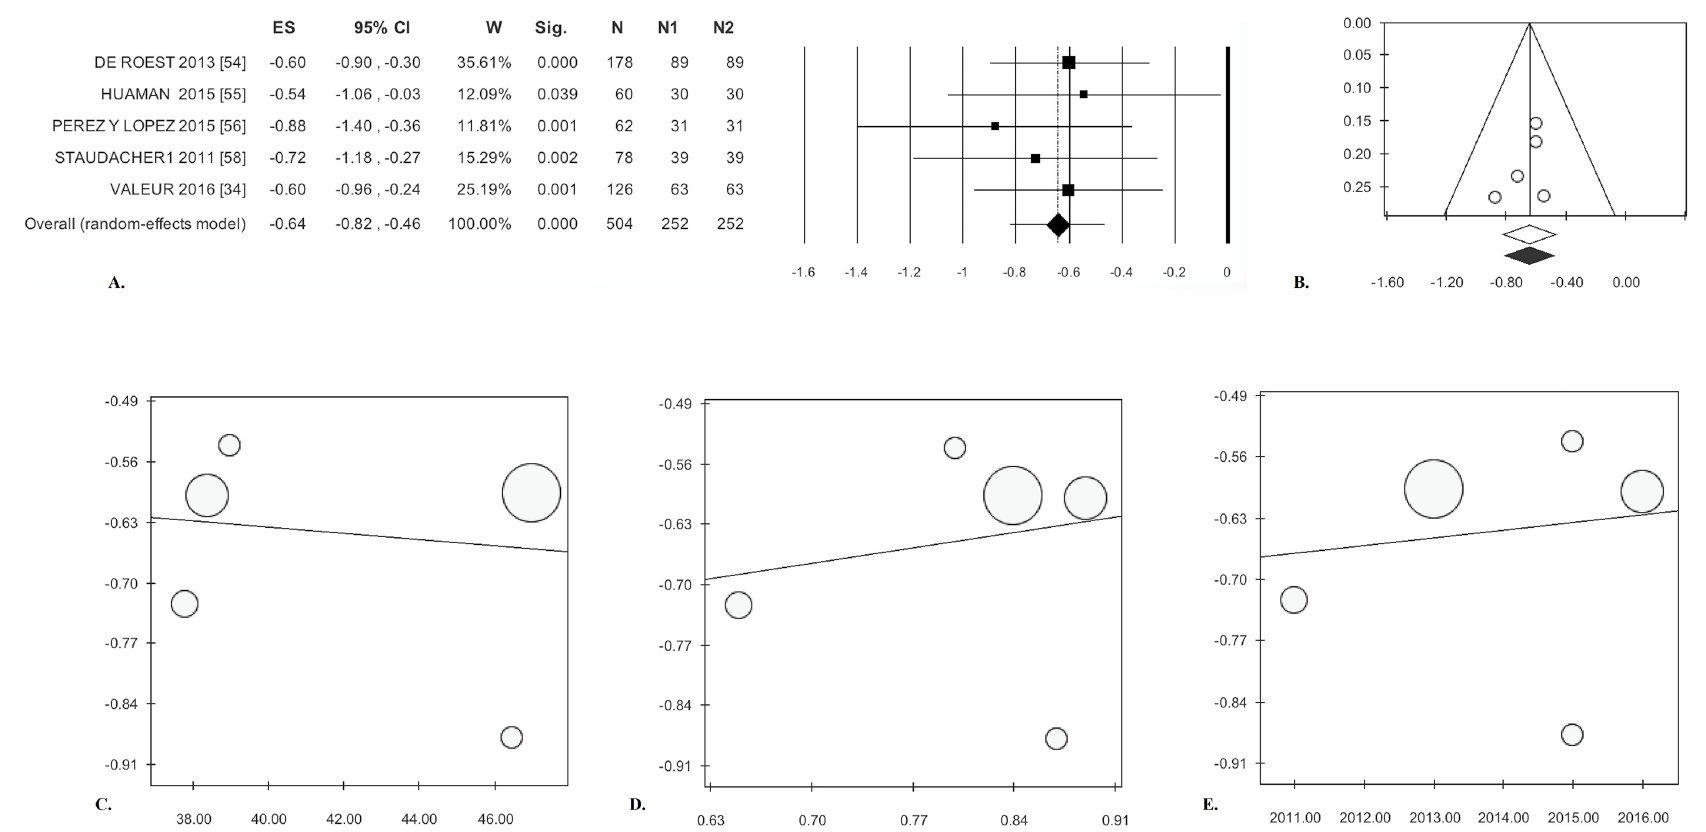
Figure 6. Low ‐ FODMAP diet in cohort studies. Bloating: ( A ) forest plot and ( B ) funnel plot. Meta ‐ regression: ( C ) mean age, ( D ) gender, and ( E ) publication year.